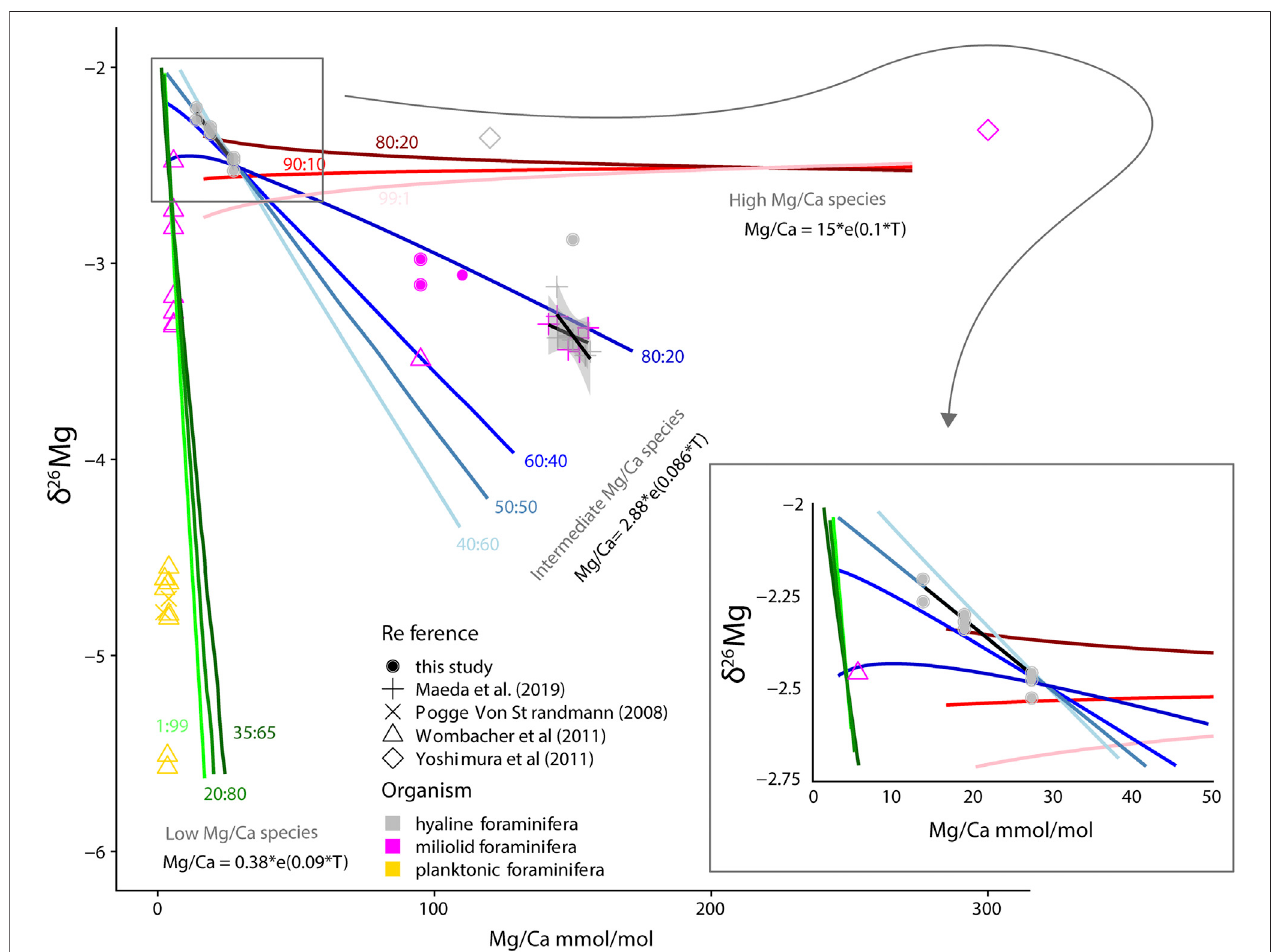
FIGURE 4 | Modelled Mg/Ca versus δ 26 Mg calculated over a range of temperatures using the species-speci fi c temperature calibrations for a number of (hypothetical)species(red,blueandgreenlines).LinesindicateisotopicsignaturesasaconsequenceofdifferentrelativeamountsoflowversushighMg/Cabands(high: low). Fitted calibration lines (black), including uncertainty intervals are added for A. lessonii (this study) as well as A. kudakajimensis and C. gaudichaudii (Maeda et al., 2019).Alsoincludedispublisheddata(PoggevonStrandmann,2008;Wombacheretal.,2011;Yoshimuraetal.,2011;Maedaetal.,2019)forcomparisonwiththe model output. When information about Mg/Ca was not available from the same study as the δ 26 Mg values, Mg/Ca was estimated using accompanying temperature information and published calibrations (Nürnberg et al., 1996; Anand et al., 2003; Raja et al., 2007; Sadekov et al., 2014; de Nooijer et al., 2017). Mg/Ca of specimens from the controlled culture experiment are based on the Mg/Ca-temperature calibration of van Dijk et al. (2019b).